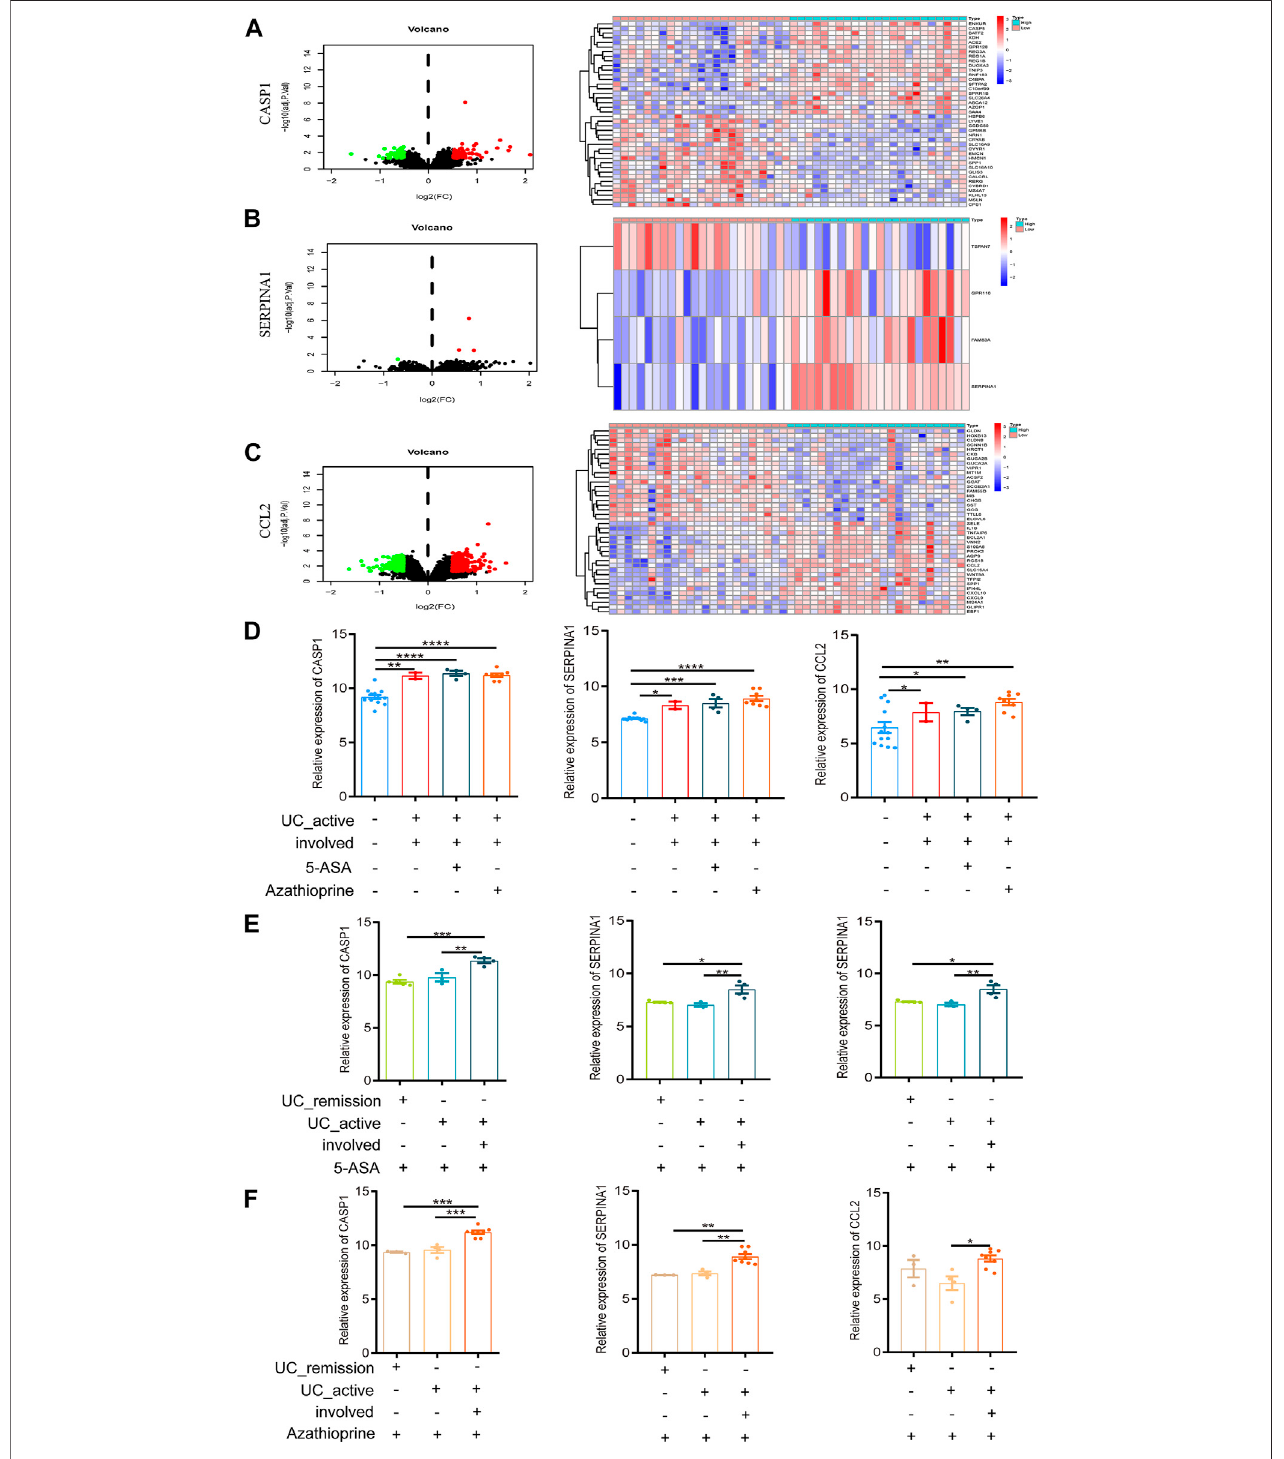
FIGURE 5 | Intestinal mucosal invasion of active UC is associated with autophagy defects. (A) The Volcano map and expression pro fi les of top 20 DEGs between high and lowCASP1 expression groups inactiveUC patients. (B) TheVolcano mapand expression pro fi les oftop 4DEGs betweenhigh andlowSERPINA1 expression groupsinactiveUCpatients. (C) TheVolcanomapandexpressionpro fi lesoftop20DEGsbetweenhighandlowCCL2expressiongroupsinactiveUCpatients. (D) The relative expression levels of CASP1, SERPINA1, and CCL2 in the involved intestinal mucosa of active UC patients treated 5-ASA or azathioprine. (E) The relative expression levels of CASP1, SERPINA1 and CCL2 in involved and non-involved intestinal mucosa of active UC patients treated with 5-ASA. (F) The relative expression levels of CASP1, SERPINA1 and CCL2 in involved and non-involved intestinal mucosa of active UC patients treated with azathioprine. UC, ulcerative colitis. DEGs, differentially expressed genes. 5-ASA, 5-aminosalicylic acid. * p < 0.05, ** p < 0.01, *** p < 0.001, **** p < 0.0001.